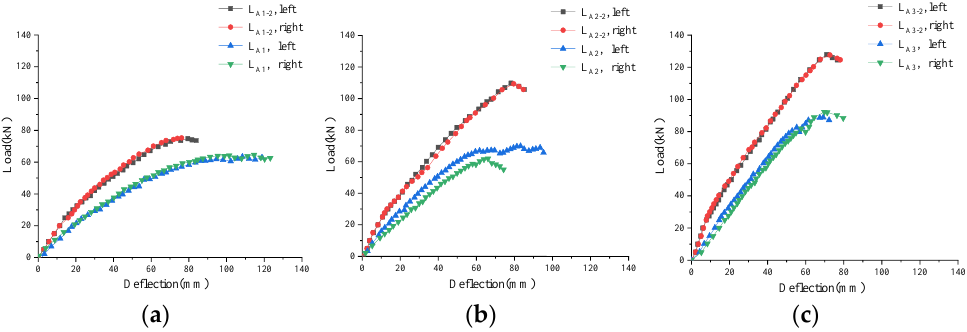
Figure 21. Load – displacement curve of group A. ( a ) 7 kN, 2 steel wires; ( b ) 7 kN, 4 steel wires; ( c ) 7 Figure 21. Load-displacement curve of group A (regulated beam). ( a ) 7 kN, 2 steel wires; ( b ) 7 kN, kN, 6 steel wires. 4 steel wires; ( c ) 7 kN, 6 steel wires.